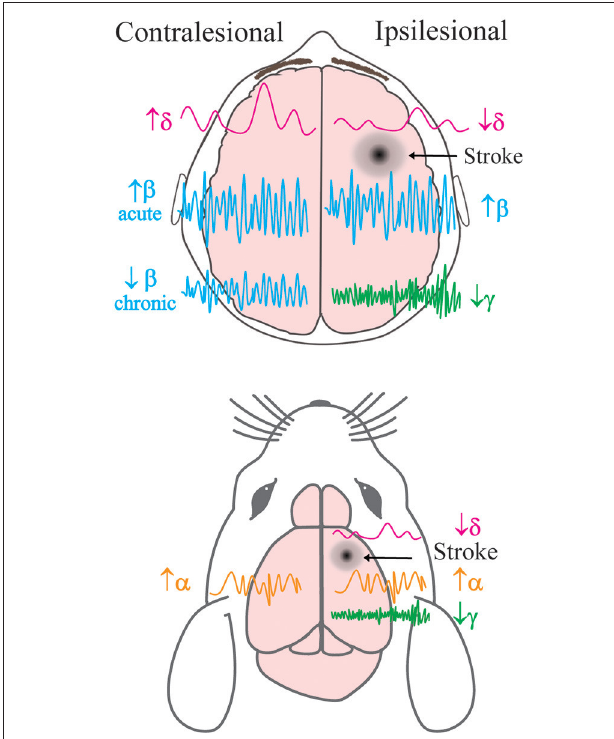
FIGURE 1 | Simplified schema of hemispheric changes to neural oscillatory power following stroke in human and animal models. Previously described alterations to the power of brain oscillations in the contralateral and ipsilesional hemispheres of human patients (top) and mice (bottom) post-stroke. δ = delta, α = alpha, β = beta, γ = gamma frequency bands. Acute refers to < 7 days after stroke, and chronic refers to > 6 months after